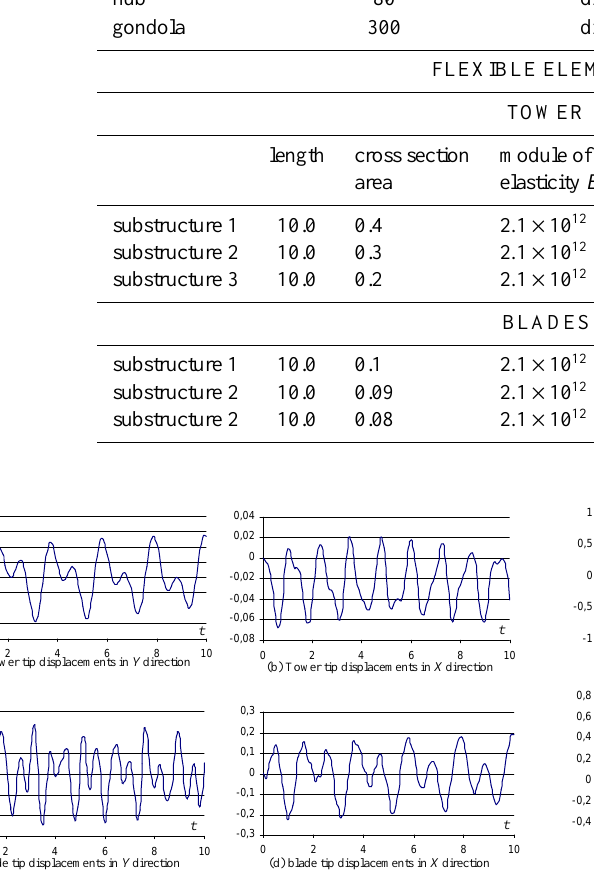
Figure 7. Displacements of the rotating WPG imposed on earth- quake. posed. Examples of motion simulation of WPG imposed on earthquake are